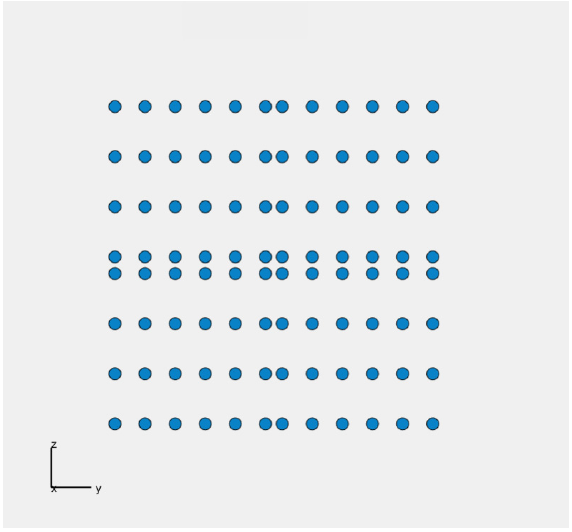
Figure 7. The positions of the microphones on the plate-shaped acoustic camera in coordinate system, x being the broadside direction — Acoustic Camera 2 .